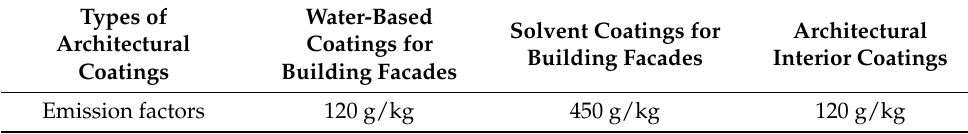
Table 1. Emission factors for VOCs in the construction